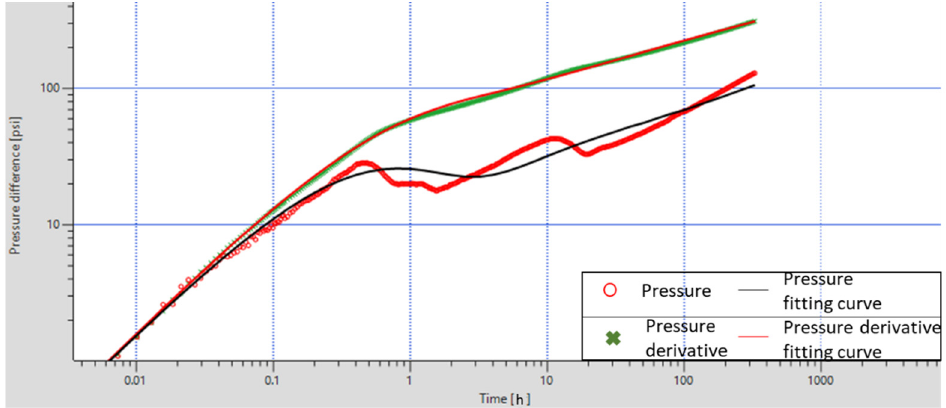
Figure 20. 10-1H well test curve. Figure 20. 10 ‐ 1H well test curve. Figure 20. 10 ‐ 1H well test curve.